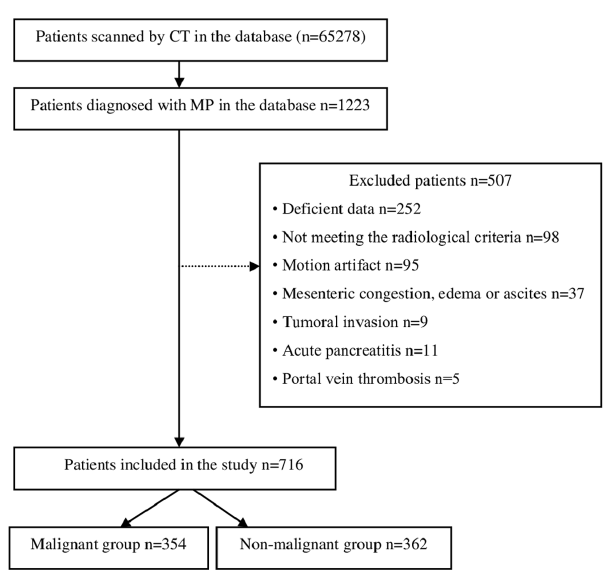
Figure 1. Consort